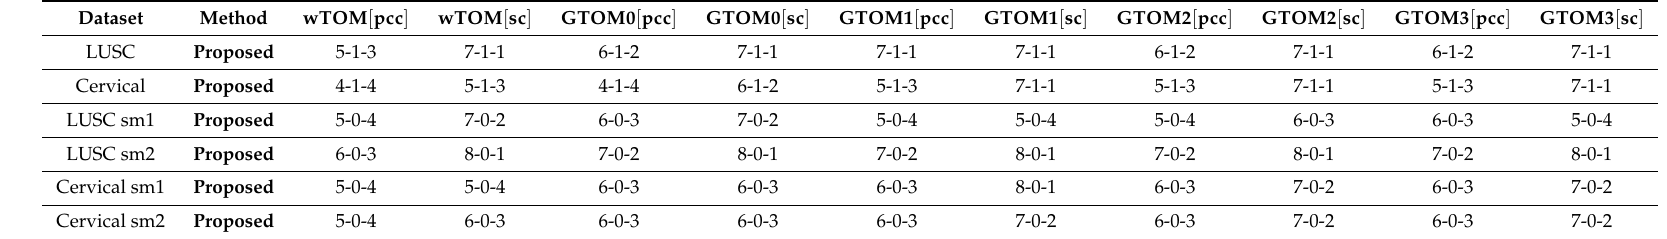
The entry at row X under column Y represents the win-draw-loss of X compared to